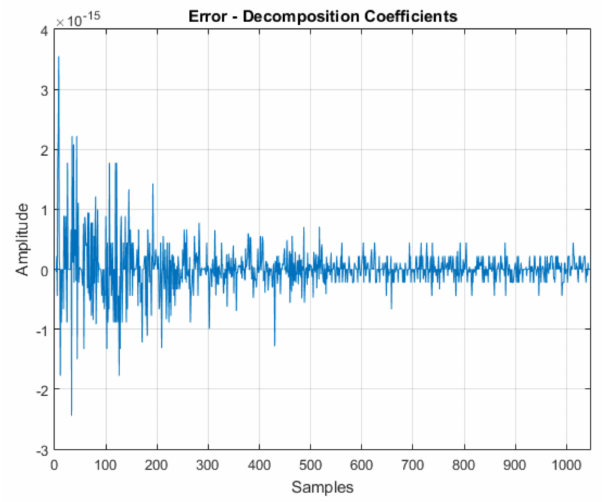
Figure 6. Error between the numerical calculation software and application results—wavelet decomposition.